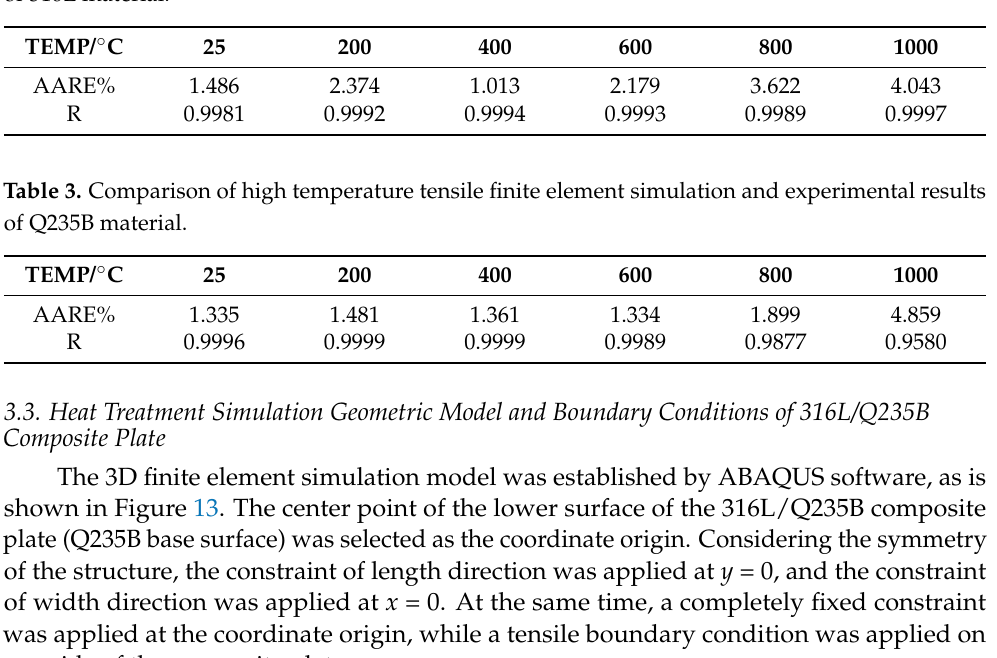
800 Figure 14. Heat treatment process. 4. Formation and Evolution Mechanism of Residual Stress In the process of the heat treatment, due to the difference in thermophysical proper- ties (thermal expansion coefficient, thermal conductivity coefficient, etc.) and mechanical properties (yield strength, elastic modulus, etc.) of each material layer of the composite plate, different degrees of strain will occur in the heterogeneous metal layer, and the un- coordinated deformation between the layers will produce interlaminar thermal stress, which will affect the stress–strain state of each material layer. If the stress of each material layer is lower than its yield point in all technological processes, plastic deformation will not occur. Conversely, if the stress of a material layer reaches or exceeds its yield strength point, plastic deformation occurs and is inherited from the next process, thus ultimately affecting the stress and strain distribution after heat treatment. As is shown in Figure 15, the 316L/Q235B composite plate was divided into 6 regions: I was the cladding layer near the surface region; II was the center region of the cladding layer; III was the cladding layer near the interface region; IV was the base layer near the interface region; V was the center region of base layer; VI was the base near the surface region. The stress and strain states of the 316L/Q235B composite plate were analyzed 0200400 600